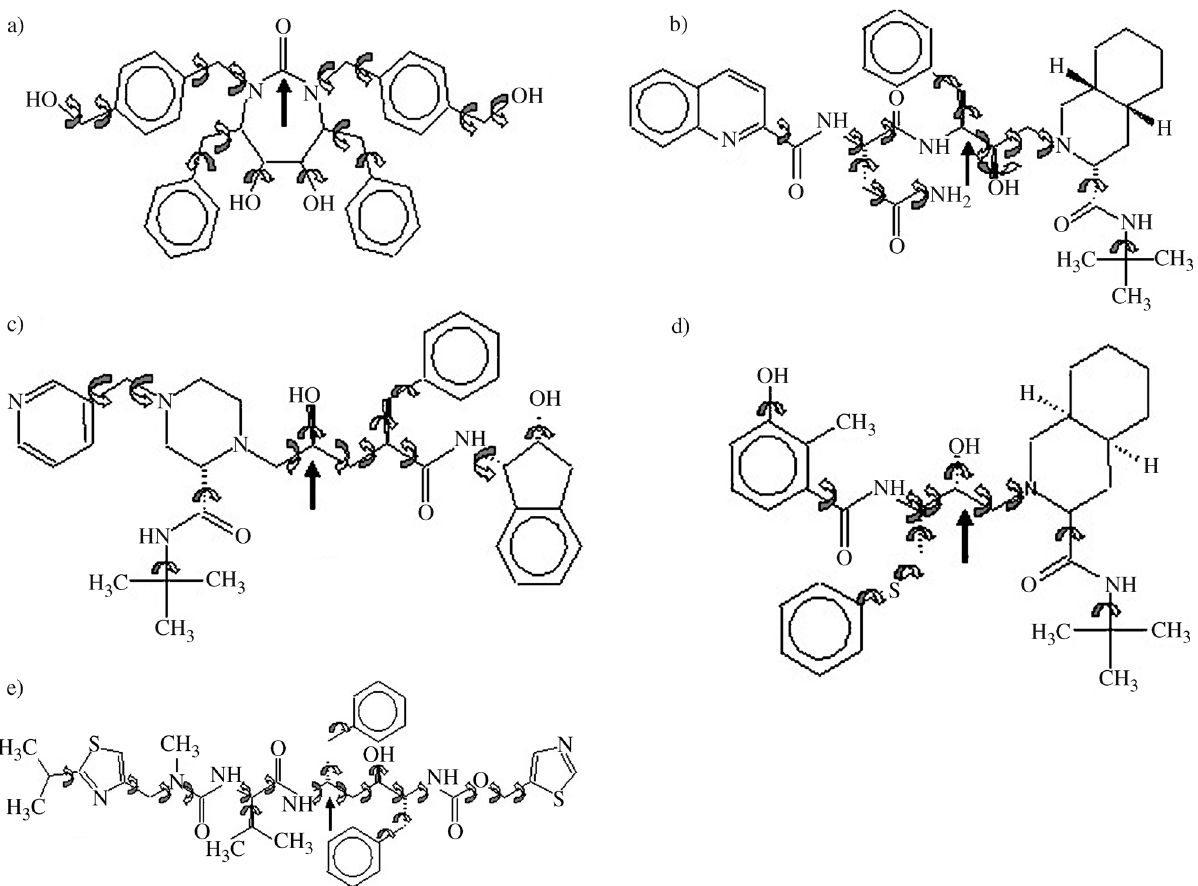
Figure 1 - HIV-1 protease ligands: (a) DMP323, (b) Saquinavir, (c) Indinavir, (d) Nelfinavir and (e) Ritonavir. The ligands’ dihedral angles are shown by curved arrows. The right arrows show the ligands’ reference atom. The more internal dihedral angles are the neighbors’ angles to the reference